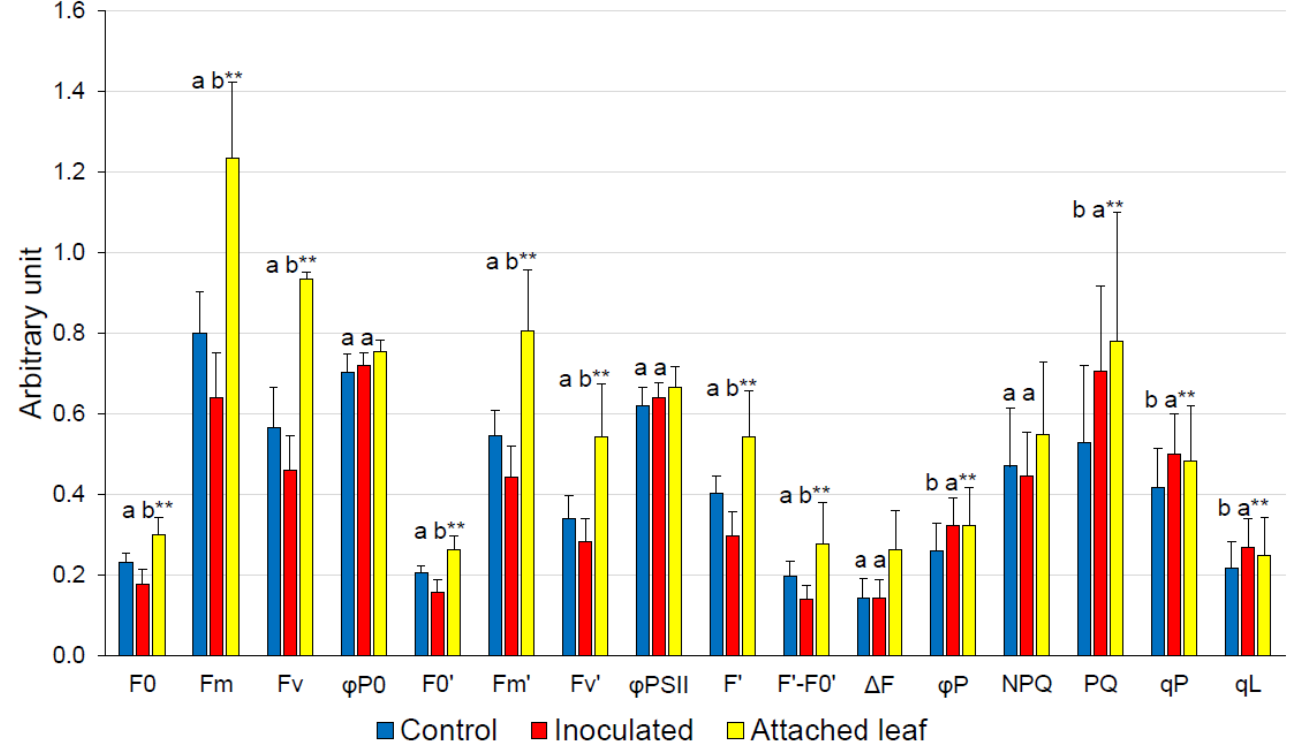
Figure 1. Saturation pulse and steady-state Chl fluorescence measurements of detached control tobacco leaves infiltrated with demineralized water ( n = 24) and detached leaves inoculated with Pto DC3000 ( n = 23) (c. 5 × 10 5 CFU mL − 1 ) compared by t -tests or Mann–Whitney U tests. Measurements of untreated attached leaves are added for comparison ( n = 20). Different letters indicate significant differences between control and inoculated detached leaves at the 5% (*) or 1% (**) significance